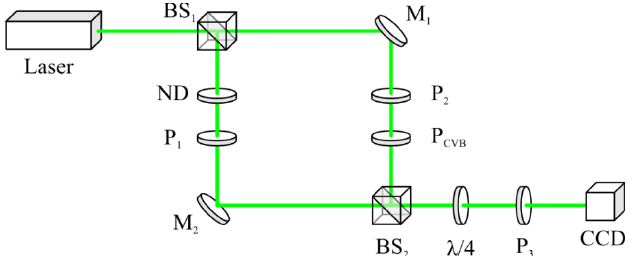
Figure 11. Optical setup. Laser is a laser MGL-F-532-700 ( λ = 532 nm, 700 mW); BS 1 , BS 2 are nonpolarizing beam splitter cubes; M 1 , M 2 are mirrors; P 1 , P 2 , P 3 are linear polarizers; ND is a neutral density filter; P CVB is a vector wave plate (LBTEK VR1-532, Shenzhen, China), λ /4 is a quarter waveplate; CCD is a camera (ToupCam UCMOS10000KPA, Hangzhou, China).